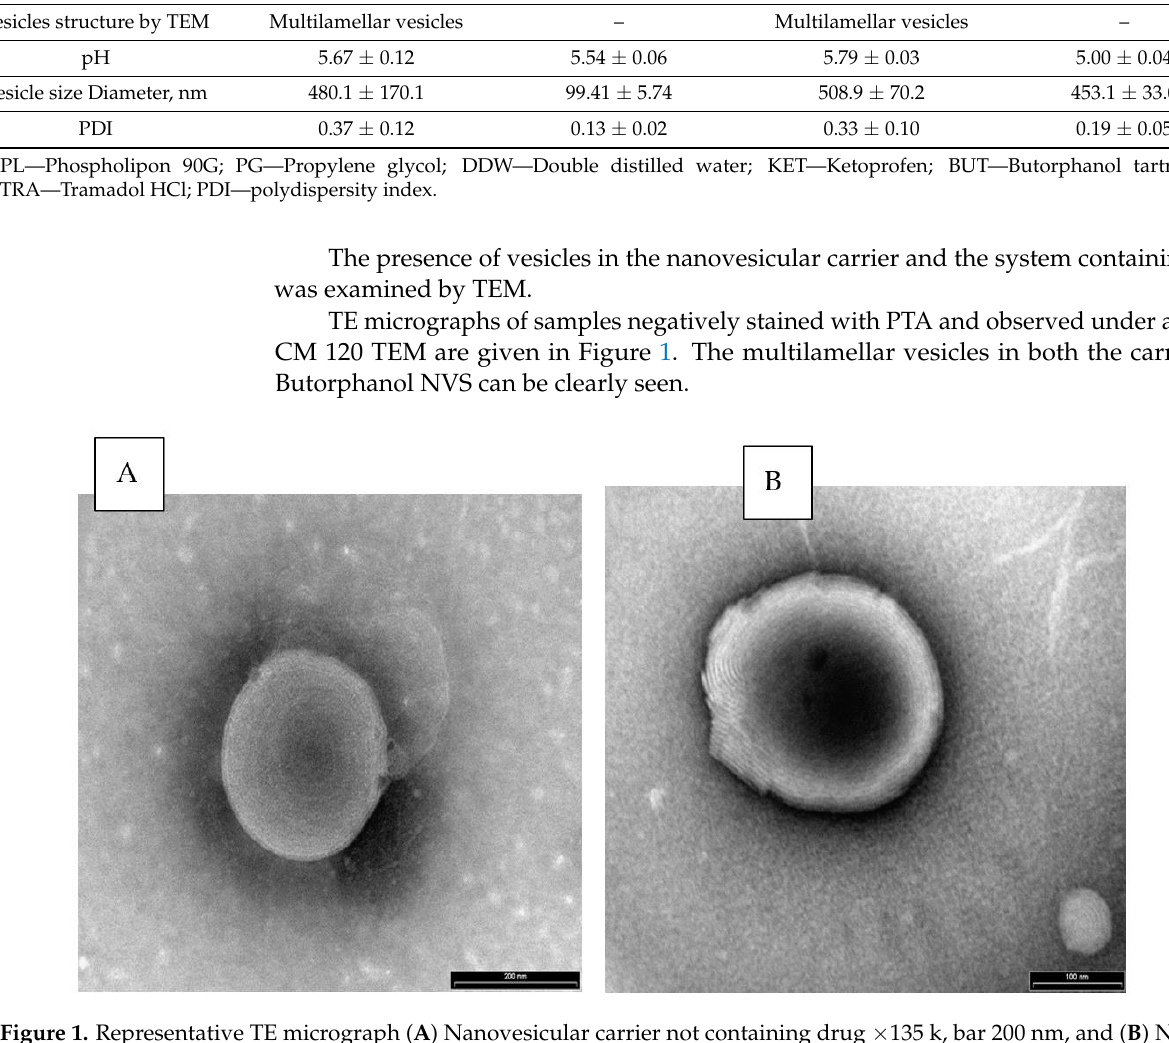
Figure 1. Representative TE micrograph ( A ) Nanovesicular carrier not containing drug ×135 k, bar 200 nm, and ( B ) NVS containing 1% Butorphanol tartrate, ×135 k bar 100 nm, Philips TECHNAI CM 120 electron microscope, Eindhoven, The Netherlands.